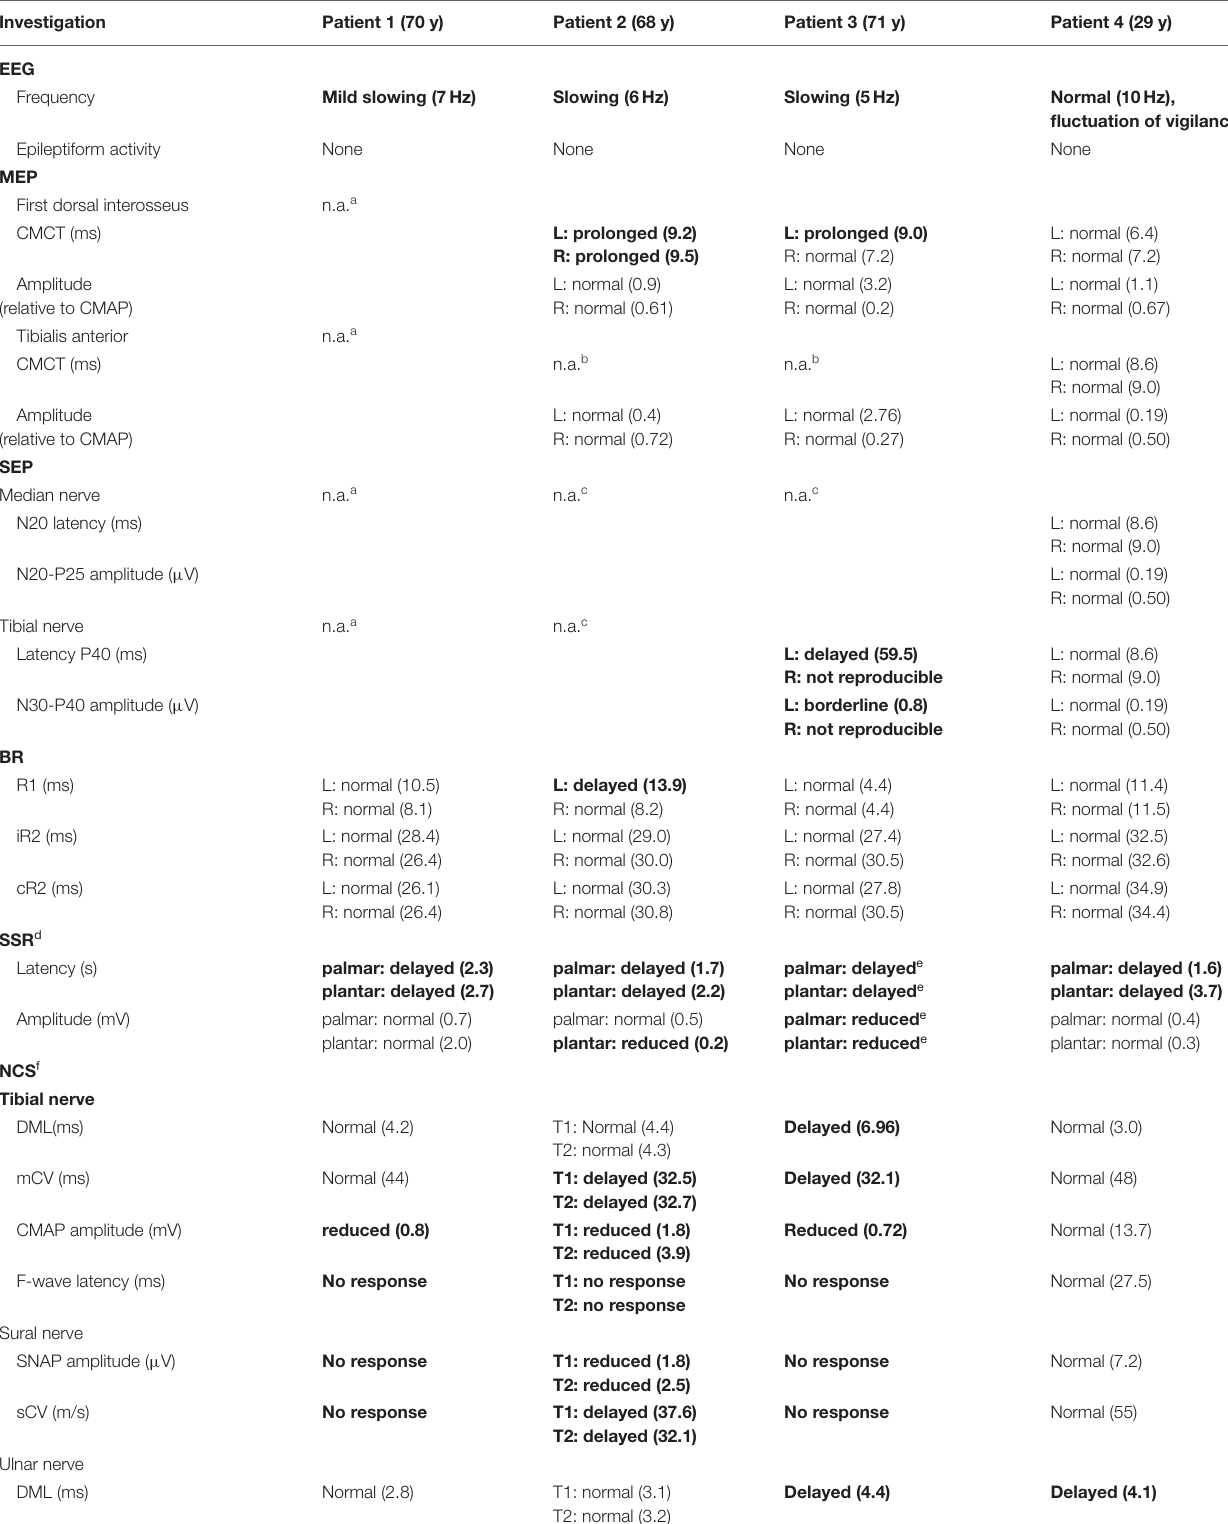
TABLE 2 | Detailed results of neuropsychological examination and multimodal electropysiological investigations.